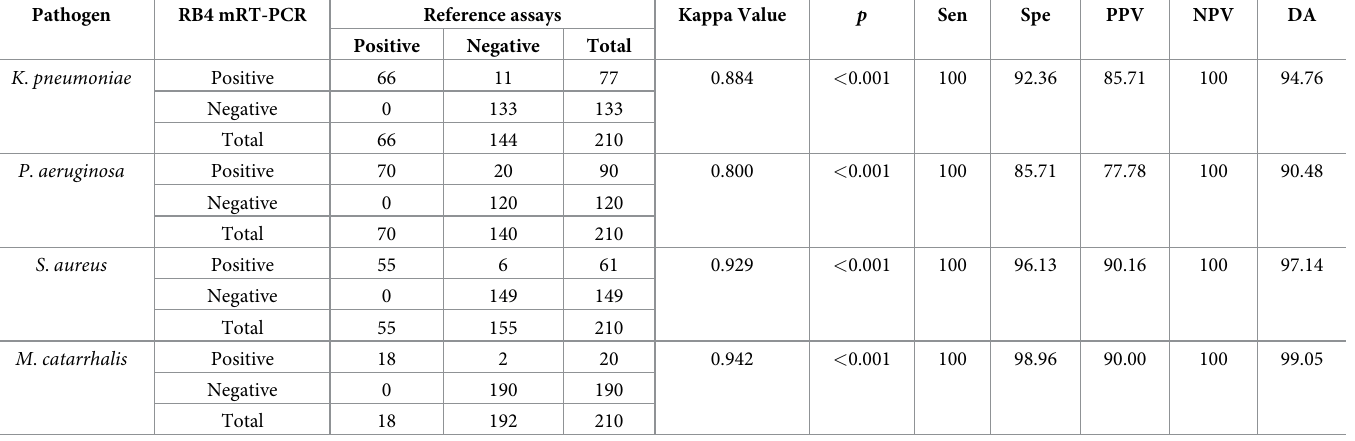
Table 5. Comparison of two platforms for the clinical qualification of target pathogens. Pathogen RB4